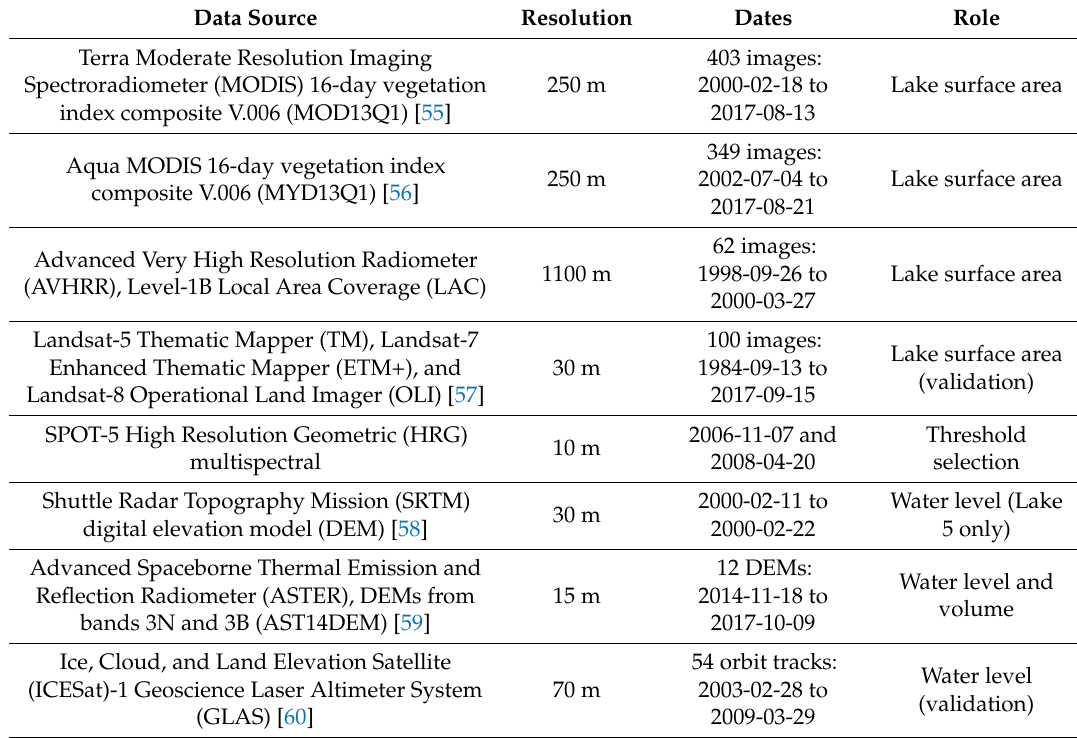
Table 2. Remote sensing data